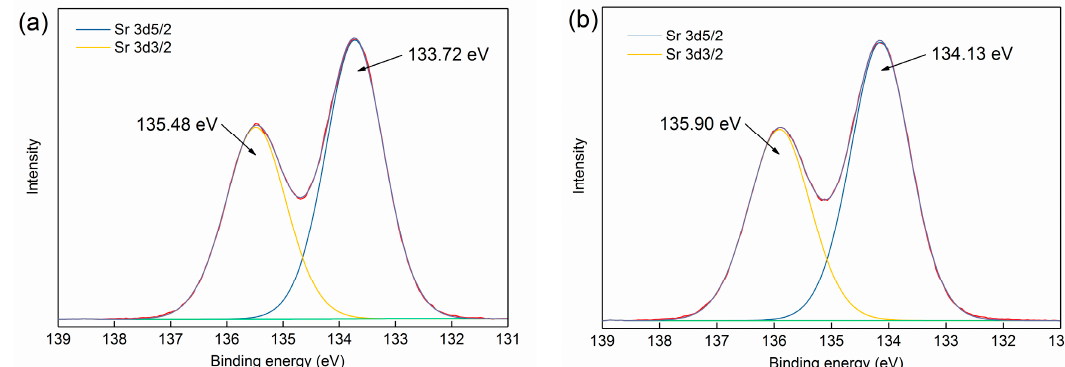
Figure 9. Sr 3d spectra of ( a ) untreated celestite and ( b ) celestite treated with ferric ions (The red lines are original curves and the green lines are background curves).